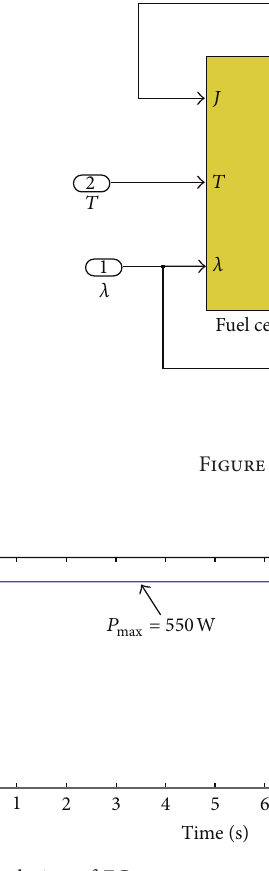
Figure 8: FC output power response given step change in hydrogen pressure.